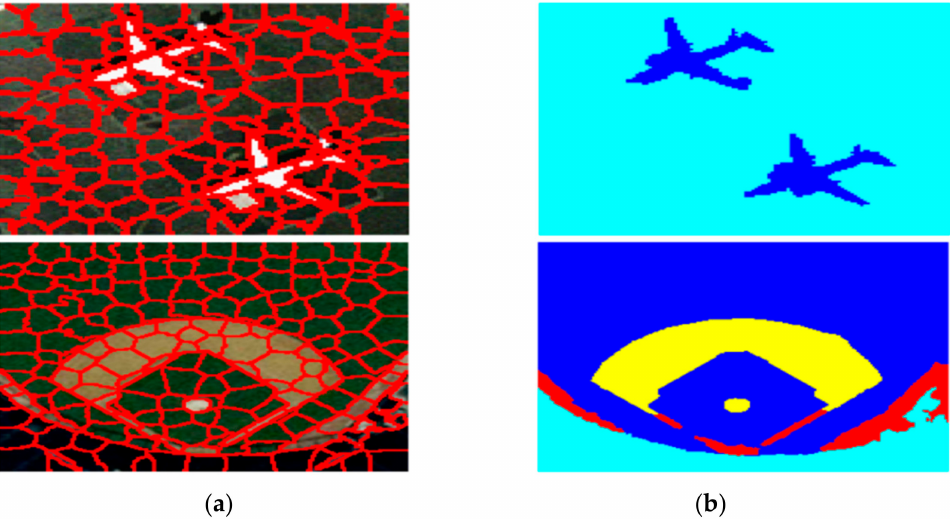
Figure 6. Results of super-pixel patterns on some remote sensing images from UCM dataset: ( a ) super- pixels patterns applied on UCM images; ( b ) homogeneous regions extracted from super-pixel pat-